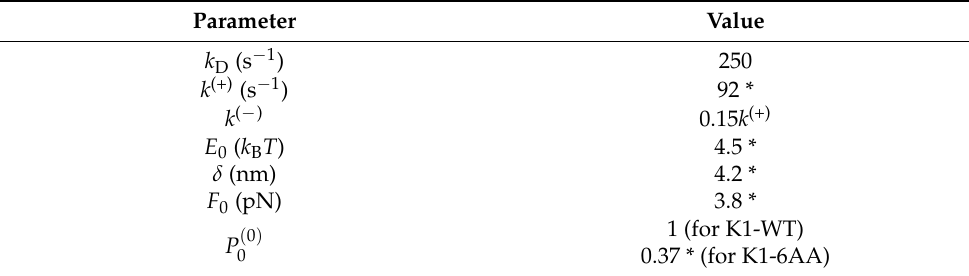
Table 2. Parameter values for human kinesin-1 motors.